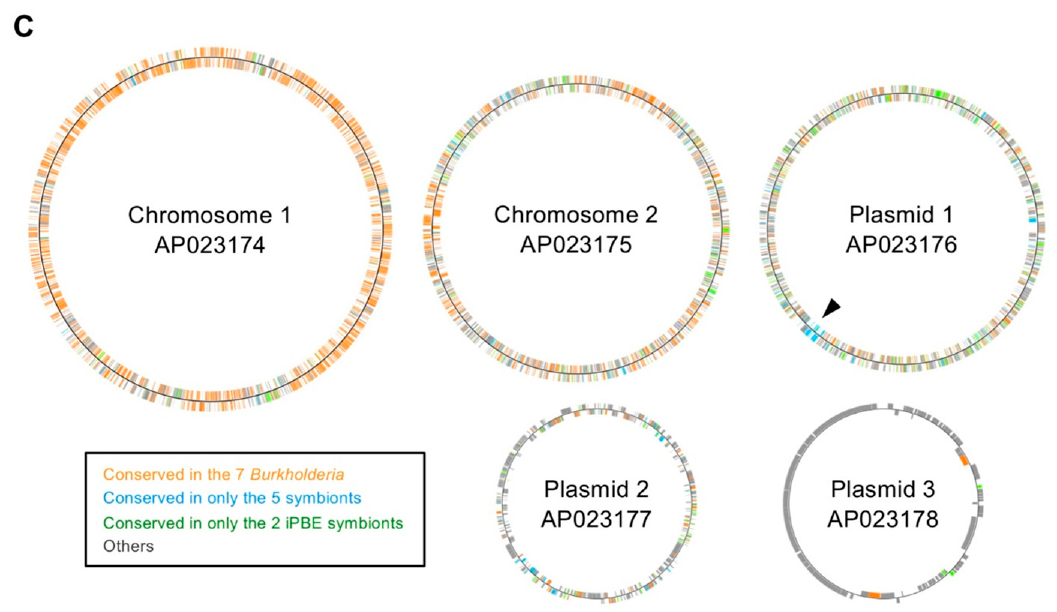
Figure 5. Comparative genomics for highlighting conserved genes among the five Burkholderia symbionts of stink bugs. ( A ) Venn diagram for the comparison between the five symbionts and the other two Burkholderia . The number of orthogroups is shown. One orthogroup may include two or more genes from a genome. ( B ) Relative abundance of the conserved orthogroups classified into each COG functional category. Since one orthogroup may be classified into two or more categories, the sum of relative abundance can be over 1. The description of each COG category is shown below the panels A and B. ( C ). The distribution of the conserved genes on the genome of the iPBE symbiont PGU16. The arrowhead indicates the region that contains the cluster of conserved genes in the five symbionts.